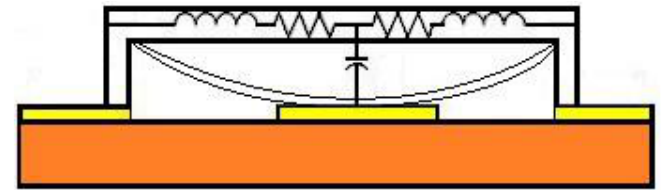
Figure 2. Model of a MEMS switch in a working state.